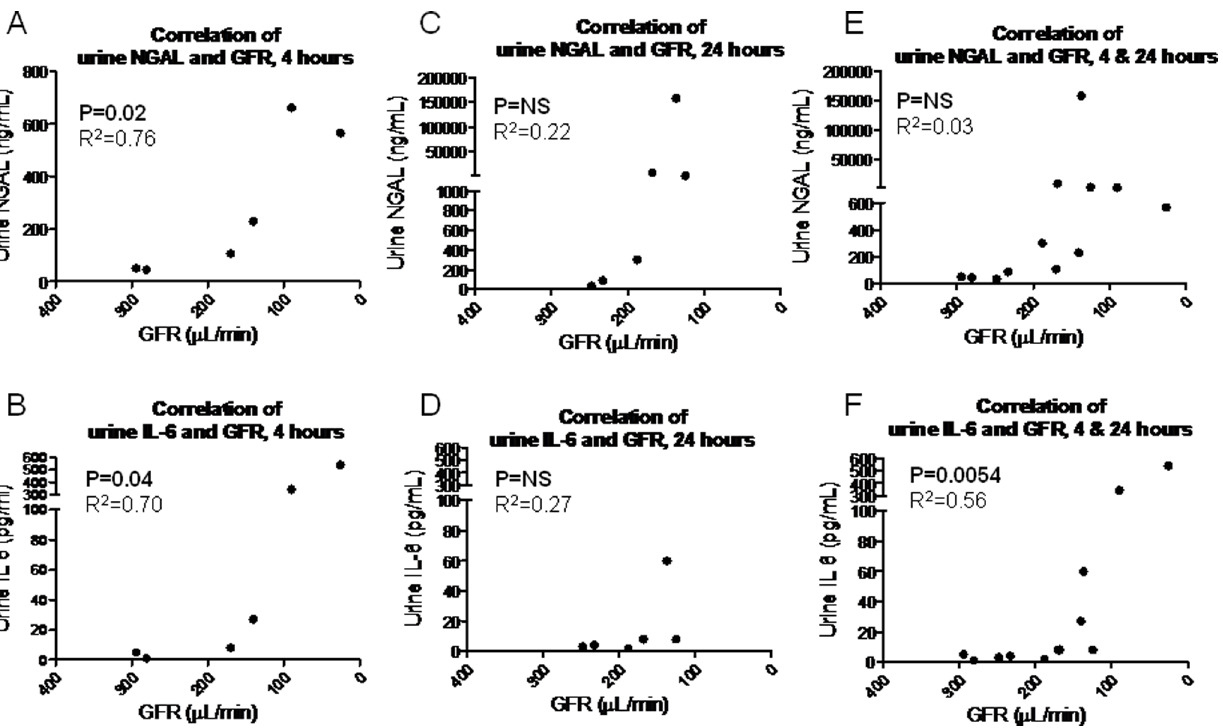
Figure 5. Performance of urine NGAL and urine IL-6 to reflect changes in glomerular filtration rate (GFR) after intraperitoneal endotoxin injection. Mean GFR were correlated with mean urine NGAL and mean urine IL-6 values at 4 hours only, 24 hours only, and combined values for 4 and 24 hours. (A) Urine IL-6, and (B) urine NGAL correlated well with GFR at 4 hours post endotoxin injection. (C) Urine NGAL and (D) urine IL-6 did not correlate with GFR at 24 hours post endotoxin injection. (E) Urine NGAL and (F) urine IL-6 performed poorly overall as markers of GFR when the 4 and 24 hours values were combined. (Figure 5). At the 24 hour time point, however, the correlation was weaker with an R 2 of 0.17; overall (4 and 24 hour values),